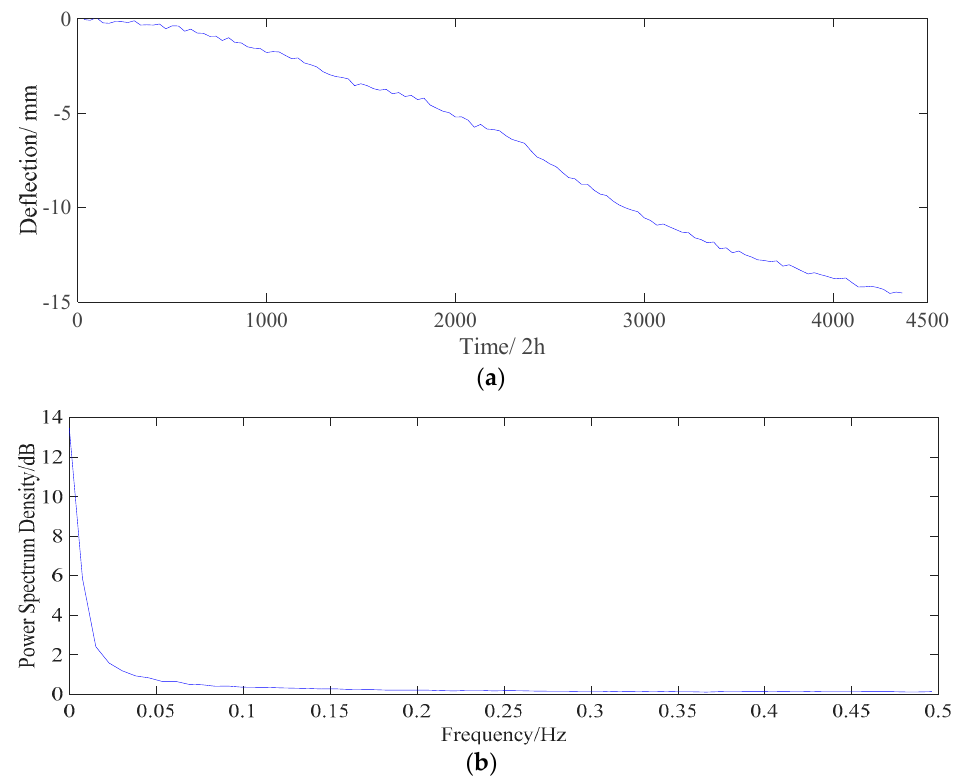
Figure 19. Separated structural deflection effect (including D S , D C , and D P ). ( a ) Time history data. ( b ) Power spectrogram.